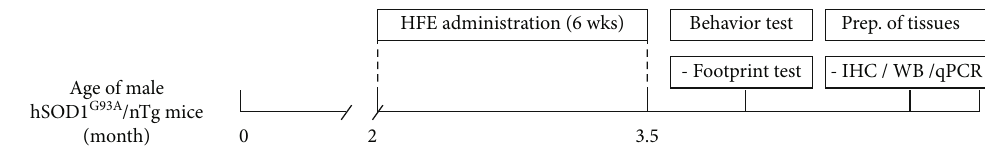
Figure 1: Timeline of experimental protocol. Herbal formula extract- (HFE-) treated hSOD1 G93A mice (Tg+ HFE, n =8) administered 1 mg/ g HFE oral injection every day for six weeks; nontransgenic (nTg, n =8) and transgenic (Tg, n =8) mice were administered distilled water. All mice were subjected to behavioral testing (footprint test) and sacri fi ced the following day. IHC: immunohistochemistry, WB: western blotting, qPCR: quantitative